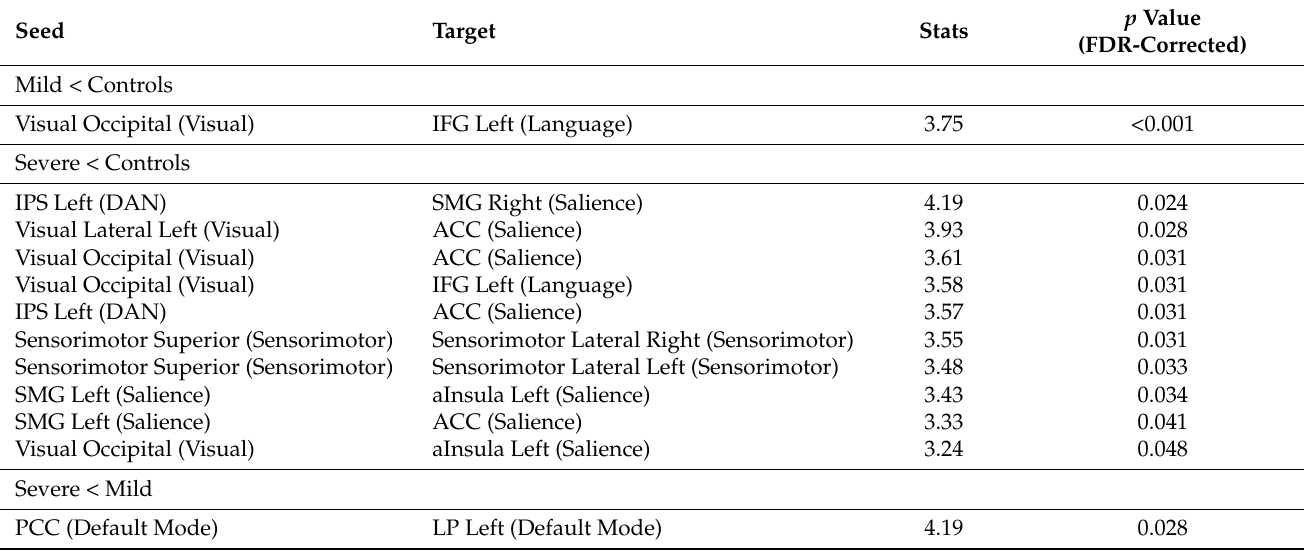
Table A3. Resting-state functional connectivity differences in